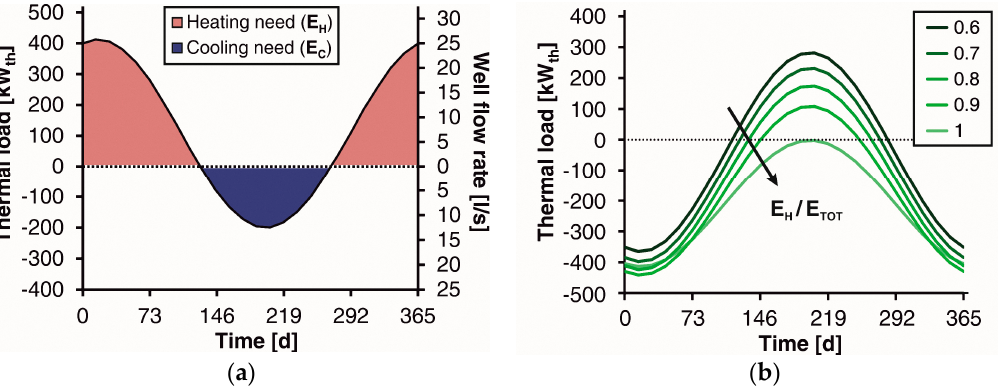
Figure 2. ( a ) Time series of the yearly-cyclic thermal load (left y -axis) and pumping/injection rates (right y -axis) applied in the well-doublet at default conditions (thick black line) and ( b ) for the heat-balance sensitivity analysis.